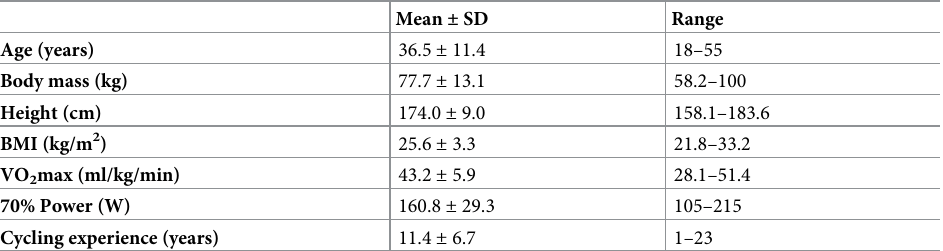
Table 1. Participant